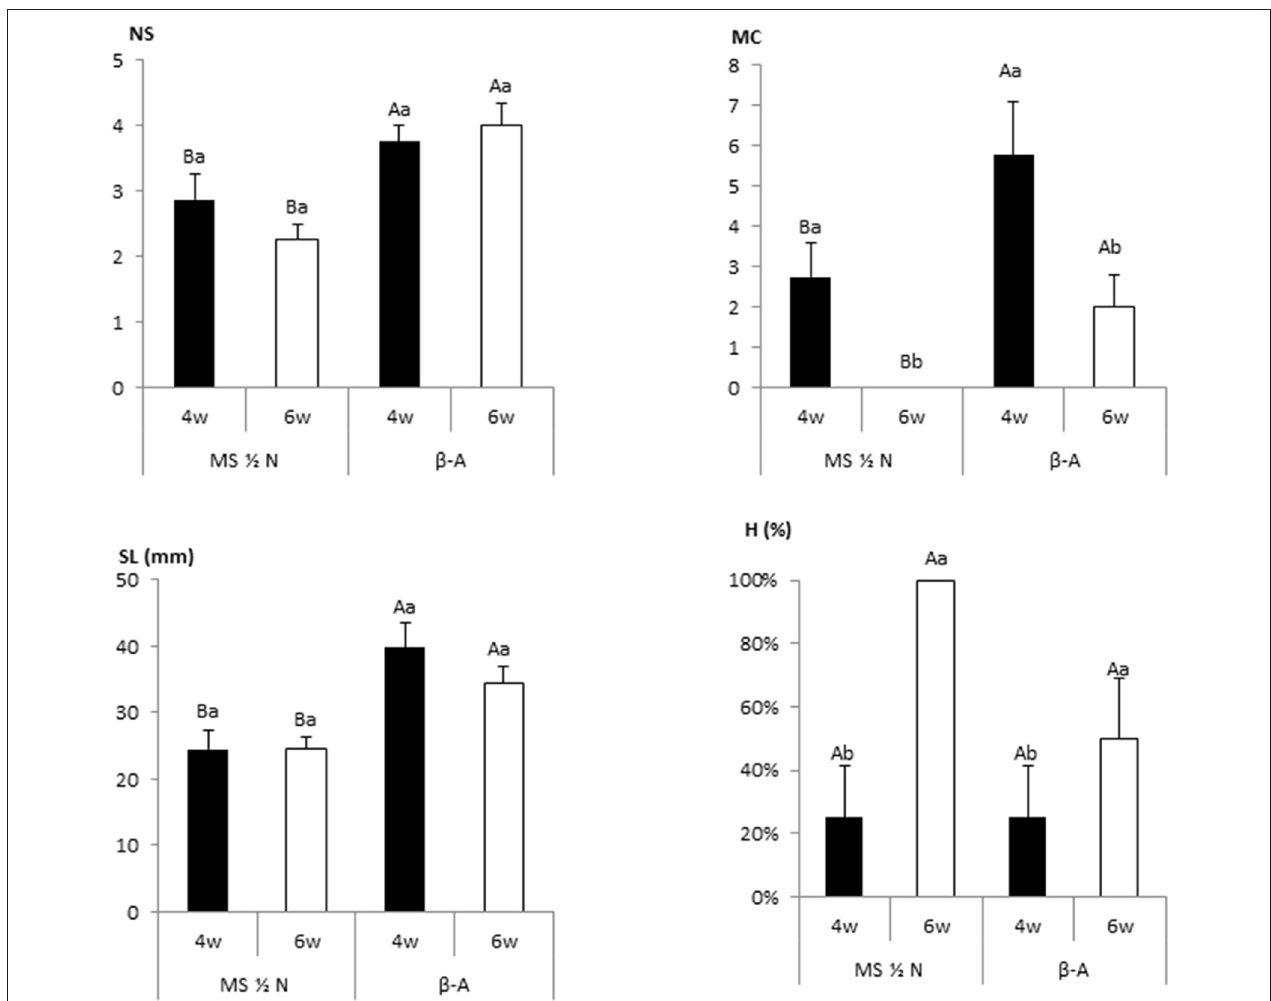
FIGURE 4 | Effect of the culture duration (4 or 6 weeks) on the growth of 8 Mati apical sections cultured in RITA ® vessels with MS medium with half-strength nitrates and β -A medium. All media were supplemented with 2- µ M metatopoline. The data recorded after 4 or 6 weeks of culture. The values represent the mean ± standard error. For each variable, different uppercase letters indicate significant differences in relation to the medium, and different lowercase letters indicate significant differences in relation to the duration of the culture ( p < 0.05). NS, number of shoots per explant; MC, multiplication coefficient; SL, length of the longest shoot (mm); H, percentage of hyperhydric